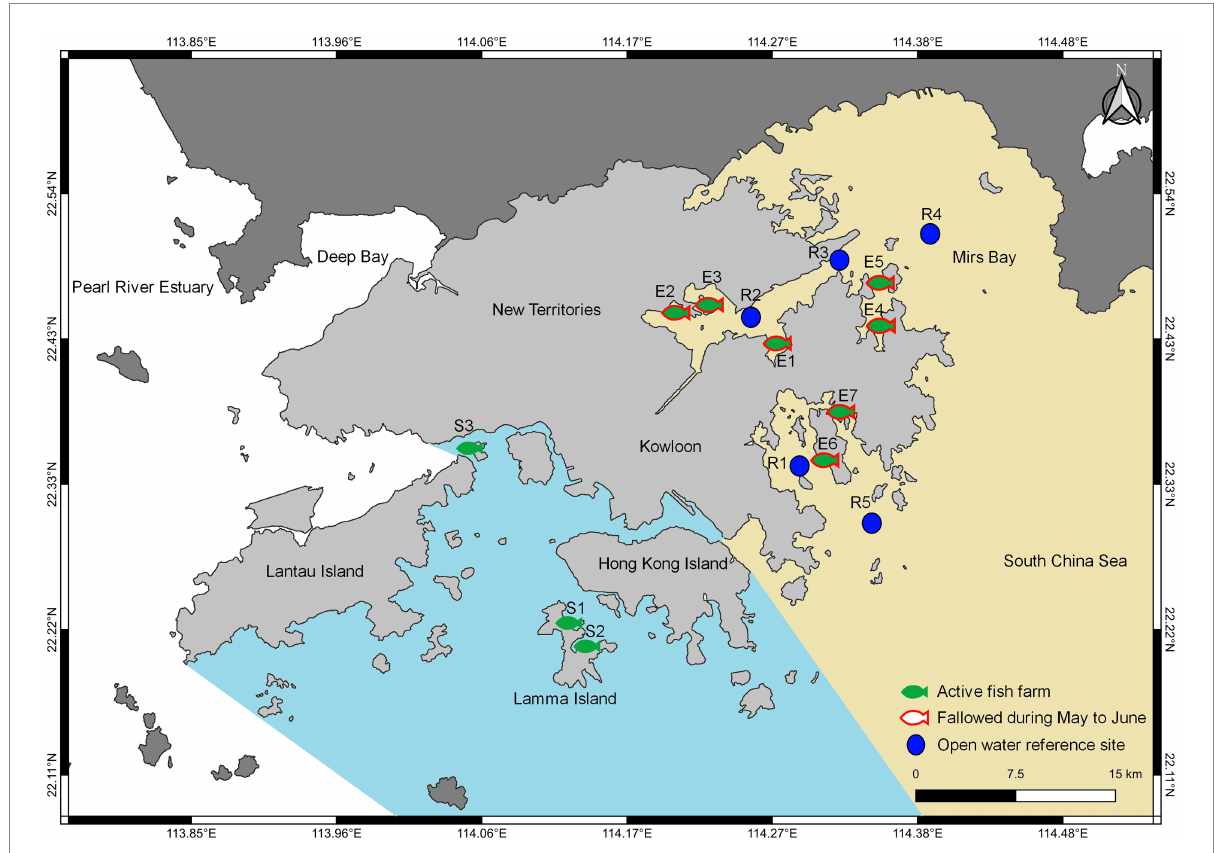
FIGURE 1 Map of sampling sites in Hong Kong conducted between September 2020 and August 2021. Fish farm sites were indicated based on temporal aquaculture activity and grouped according to geographic